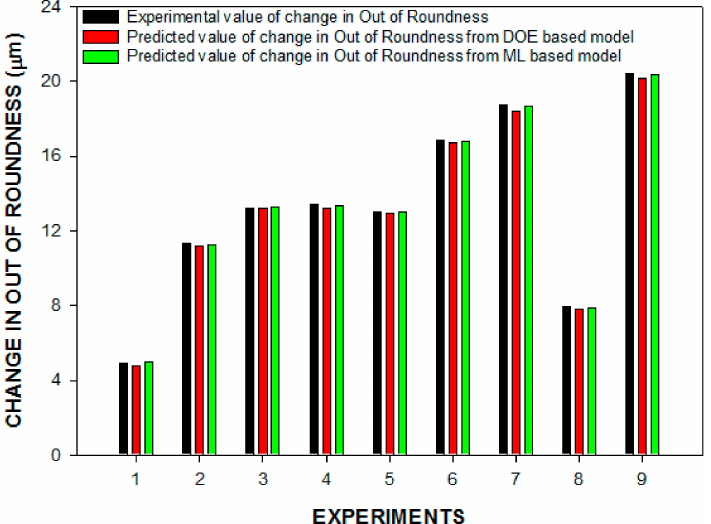
Figure 25. Comparison of DOE model and machine learning model with experimental findings for change in